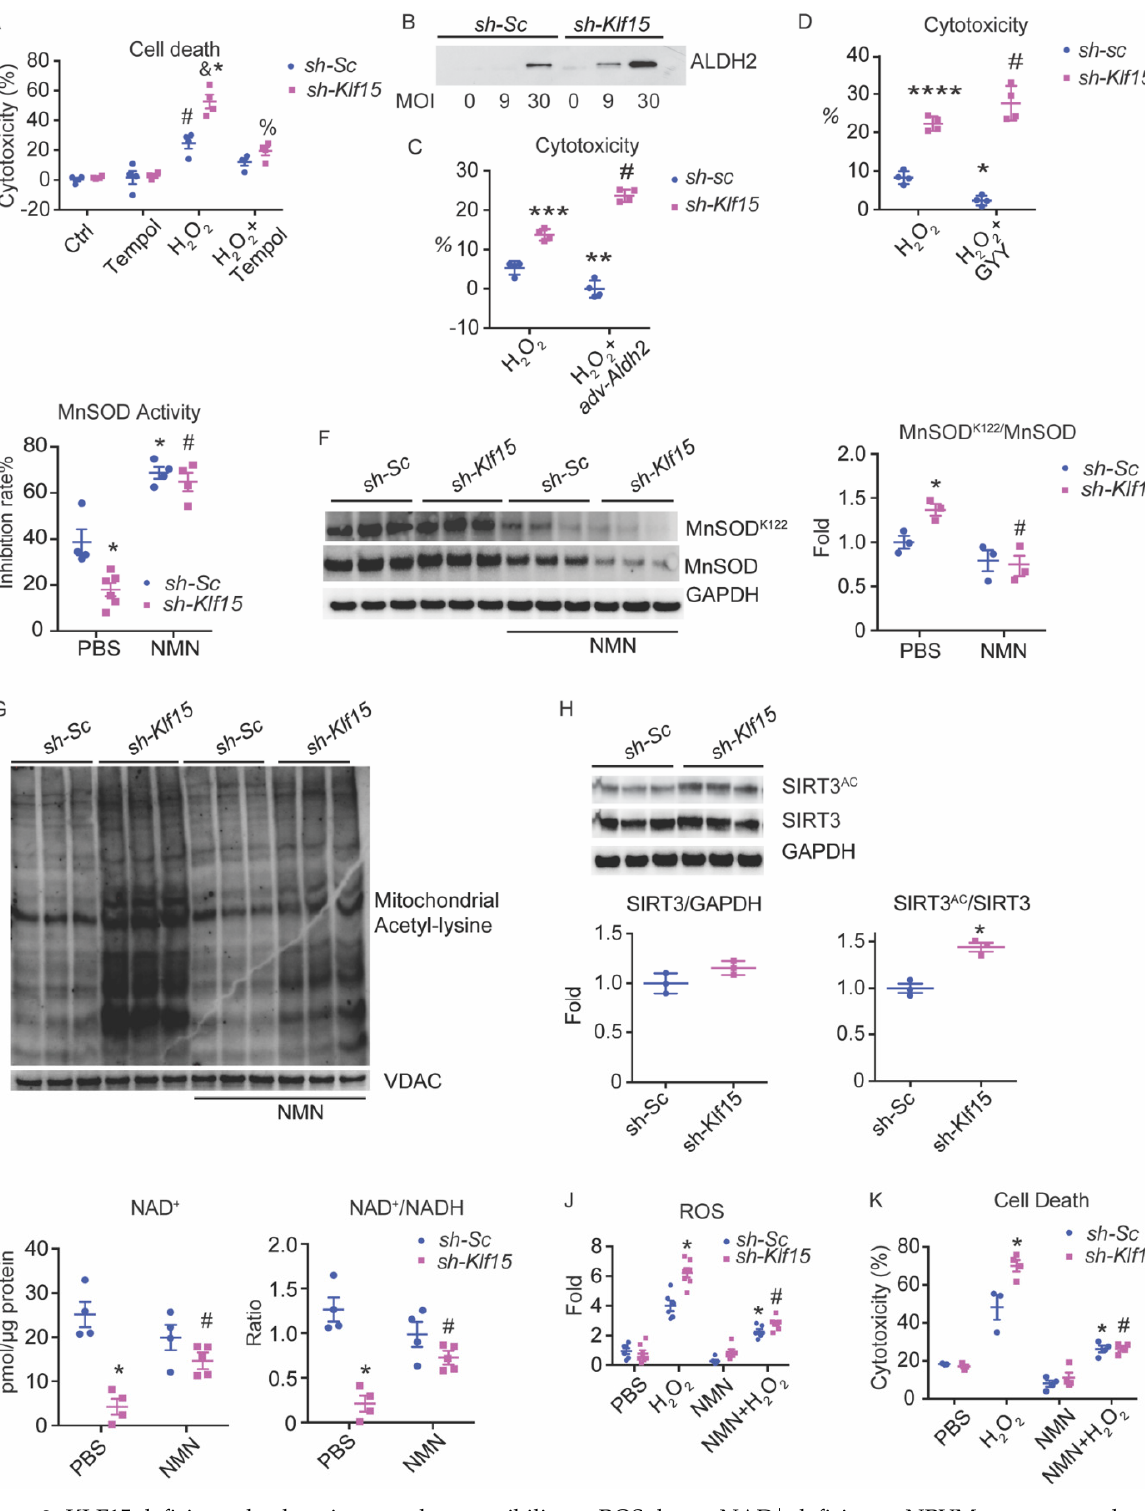
Figure 2. KLF15 deficiency leads to increased susceptibility to ROS due to NAD + deficiency. NRVMs were treated with shRNA knockdown of scrambled RNA ( sh-Sc ) or Klf15 ( sh-Klf15 ). ( A ) NRVMs were subjected to 3 mM Tempol for 10 min prior to 100 μ M H 2 O 2 for 2 h. Percentage of cytotoxicity derived from LDH assay after treatment is shown. ( n = 4, *: p < 0.0001 vs. sh-Sc without treatment; #: p < 0.04 vs. sh-Sc without treatment; &: p < 0.001 vs. sh-Sc treated with H 2 O 2 ; %: p < 0.0002 vs. sh-Klf15 treated with H 2 O 2 ). ( B ) Ectopic ALDH2 expression by adenoviral vector in NRVMs detected by immunoblotting. ( C ) NRVMs were infected with control adenoviral vector ( adv-Gfp ) or adv-Aldh2 for 48 h. Cell death was then induced by 100 μ M H 2 O 2 for 90 min before measurement by LDH assay. ( n = 3–4, **: p < 0.01, ***: p = 0.0001 vs. sh-Sc treated with H 2 O 2 and infected with adv-Gfp , #: p < 0.0001 vs. sh-Sc treated with H 2 O 2 and infected with adv-Aldh2 ). ( D )